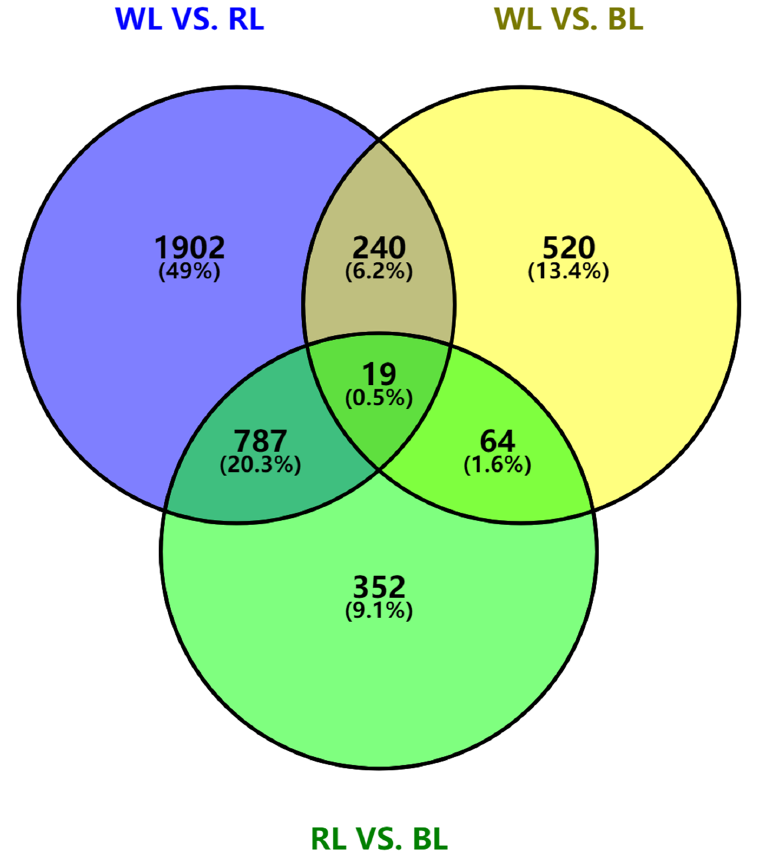
Figure 4. Differentially expressed genes (DEGs) Venn diagram analysis of C. oleifera leaves under different light conditions.